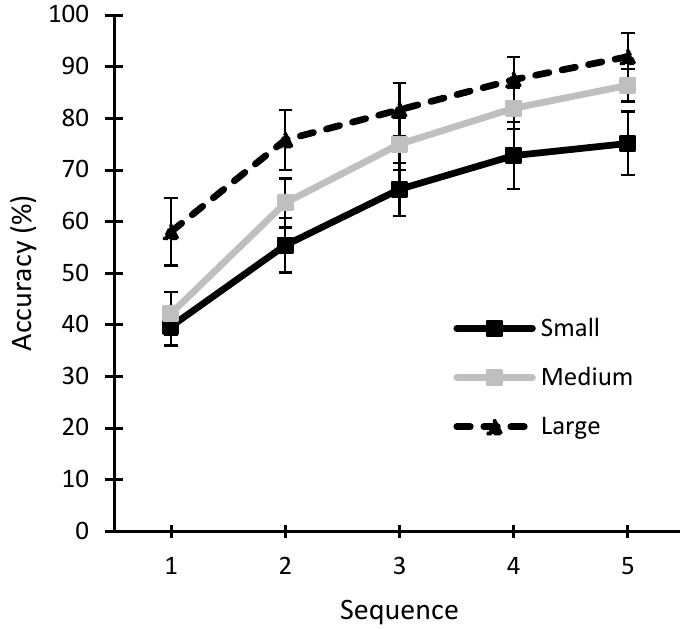
Figure 2. Accuracy (mean ± standard error) of the different conditions (small, medium, and large sizes) as a function of the number of sequences used.